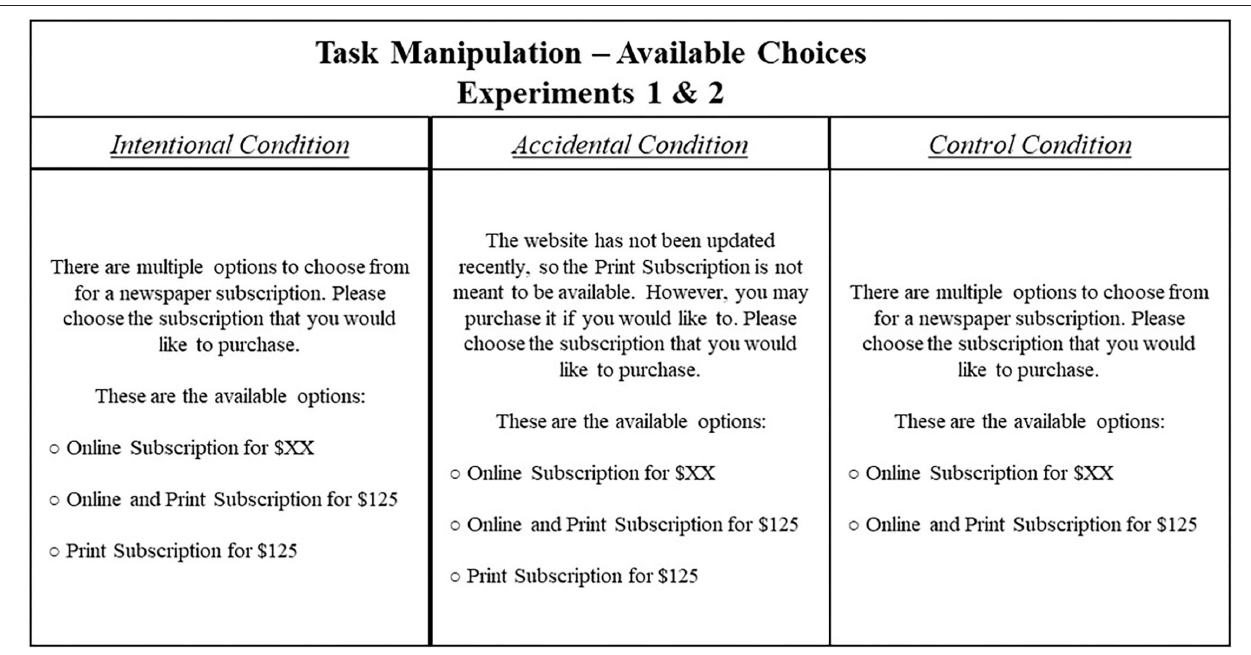
FIGURE 1 | Task manipulation performed in Experiments 1 and 2. Here, participants completed an online survey similar to a past work on the relativity of available choices (see Ariely, 2010). In all conditions, participants are presented with multiple options for purchasing a newspaper subscription: access to an online-only version, access to a joint online-and-print version, and (within the Intentional and Random conditions, only) a print-only version. Importantly, the presentation of these options varied across conditions in regard to the print-only version—with a purposeful inclusion in the Intentional condition, an unintentional inclusion in the Accidental condition, and an exclusion from the Control condition. Between experiments, the price of the online-only subscription was changed. In Experiment 1, $XX = $59. In Experiment 2, $XX = 99. proportion; χ 2 (1, n = 71) = 1.0, p = 0.32] nor